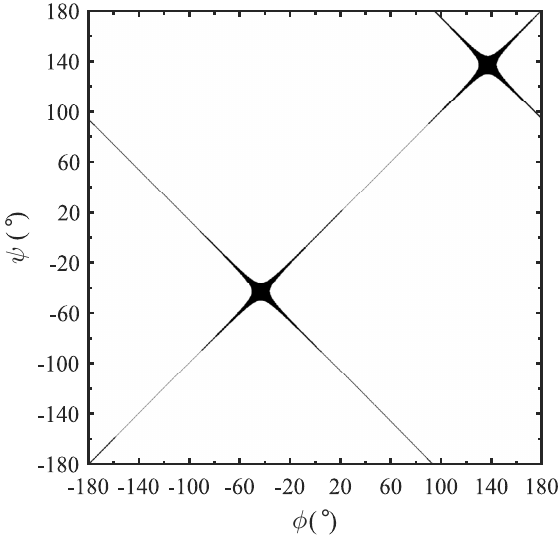
Figure 6. Phase sweep plot when the distance to the vertex is zero. The black trace represents those combinations of ψ , φ that yields | J N + 1 | = 1. For illustration purpose all | J N + 1 | values that fit in 1 ± 0.001 have been